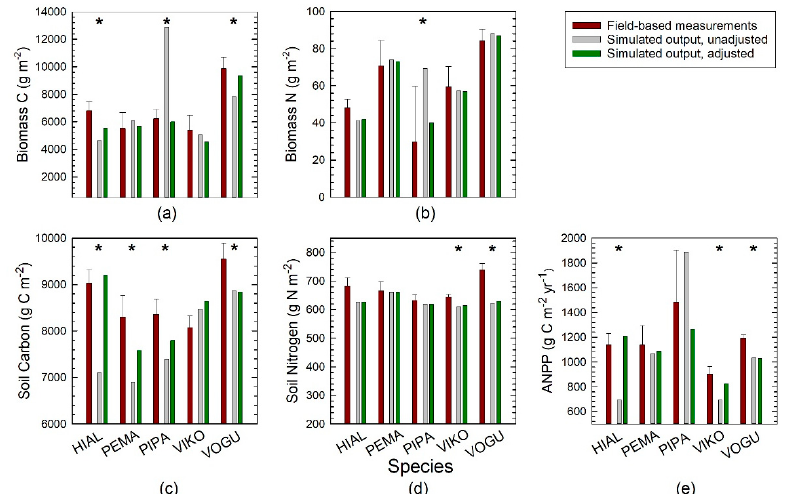
Figure 6. Comparison of measured and simulated effects of five tropical tree species on ecosystem processes and properties. ( a , b ) Aboveground biomass C and N. ( c , d ) Soil organic C and N (0–30 cm). ( e ) Aboveground net primary productivity (ANPP). Four-letter acronyms for tree species at La Selva are given in the text. Measured values (means ± standard error, n = 4) are based on the years 2003– 2005 of the long-term, field-based experiment [18,30]. An asterisk denotes that uncalibrated simulated values fell outside of the 95% confidence interval of measured values.